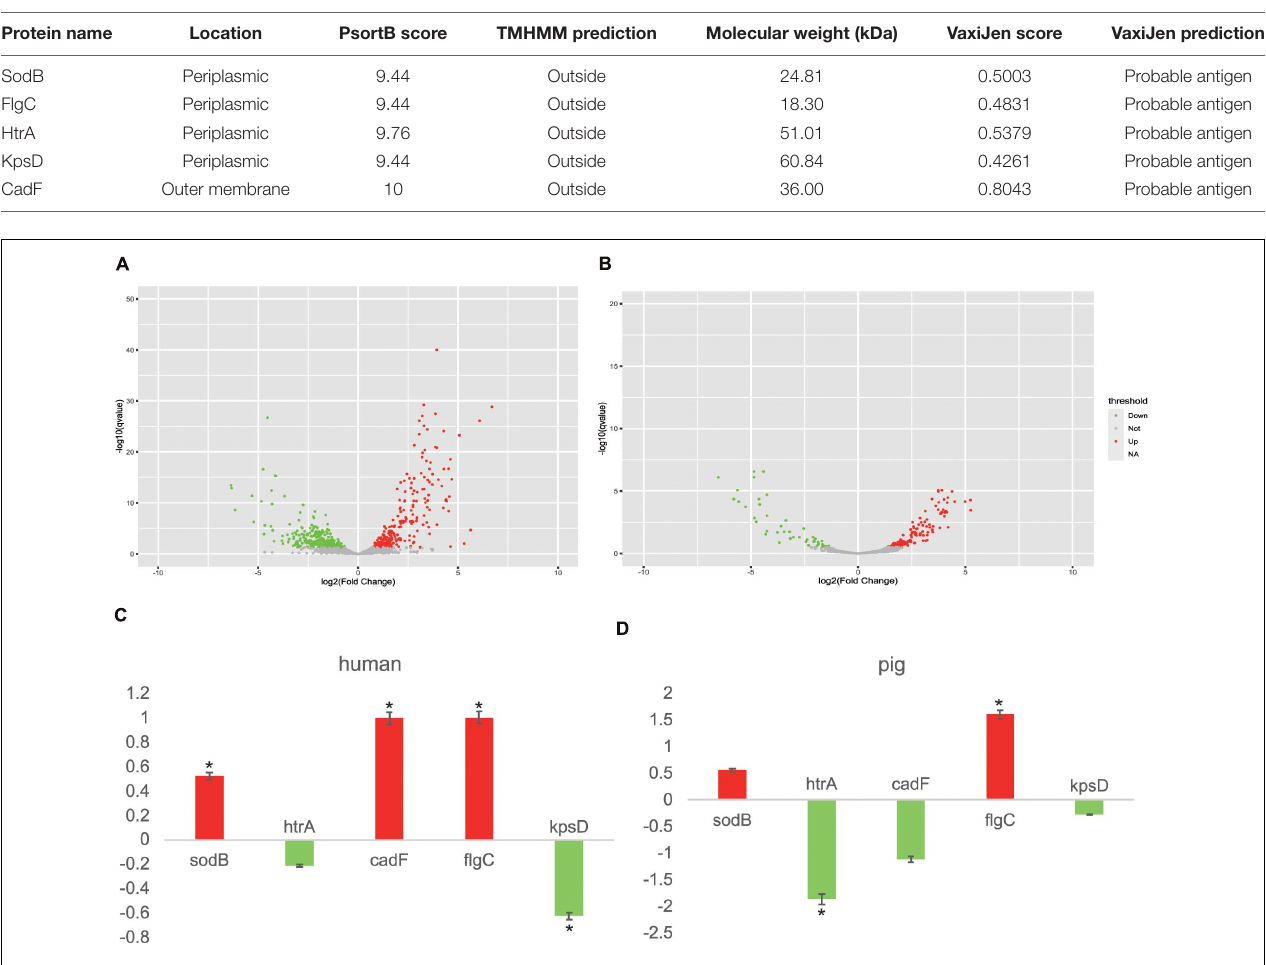
TABLE 1 | Characterization and antigenicity of the core vaccine target proteins.